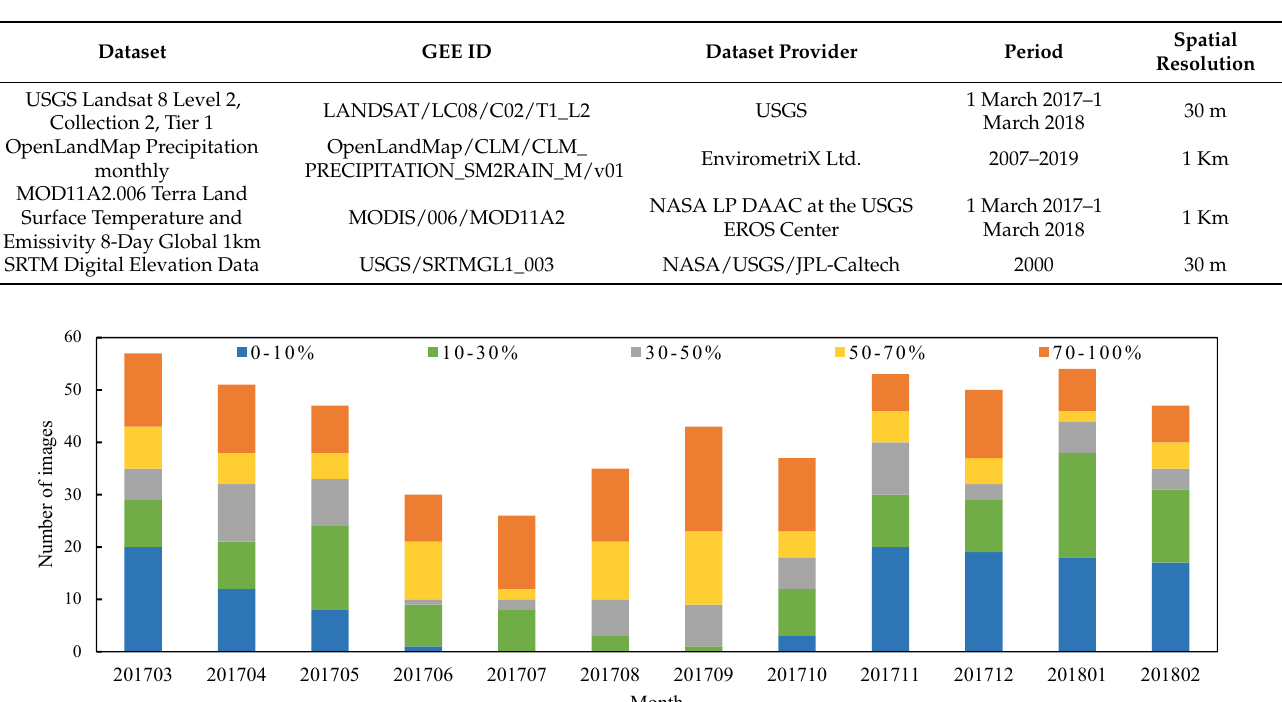
Table 1. Datasets used in this study—all are available on the GEE platform. USGS represents the United States Geological Survey.